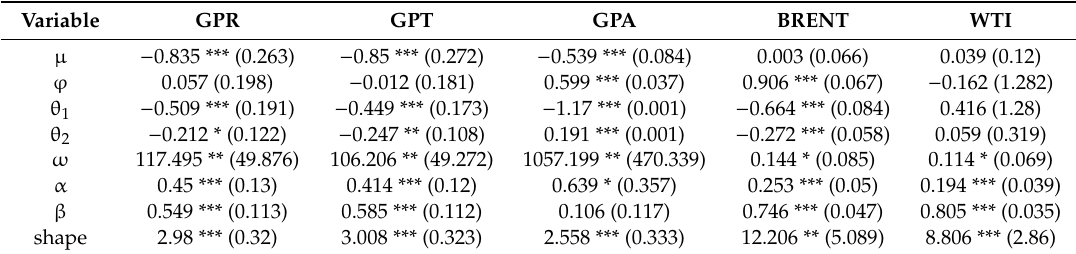
Table 2. Parameter estimation of the ARIMA-GARCH models for GPR indices and crude oil prices.